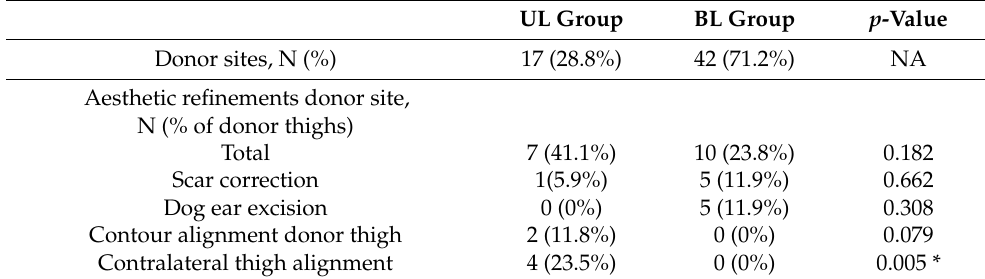
Table 3. Secondary refinement